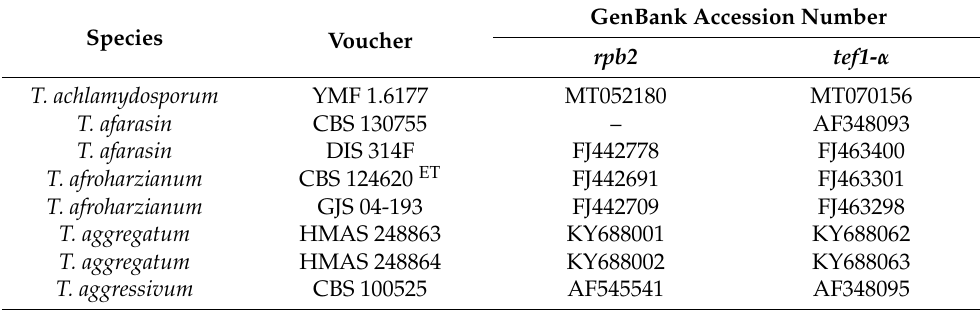
Table 1. Materials including strain numbers and GenBank accessions of sequences used for phyloge- netic